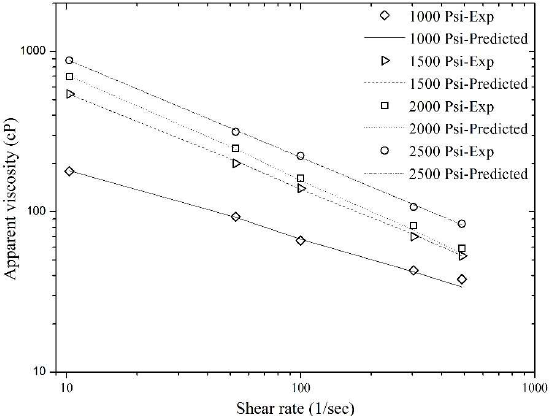
Figure 11. Match of the predicted viscosity values of sCO 2 foam using Equation (11) with the experimental data shown in Figure 6.